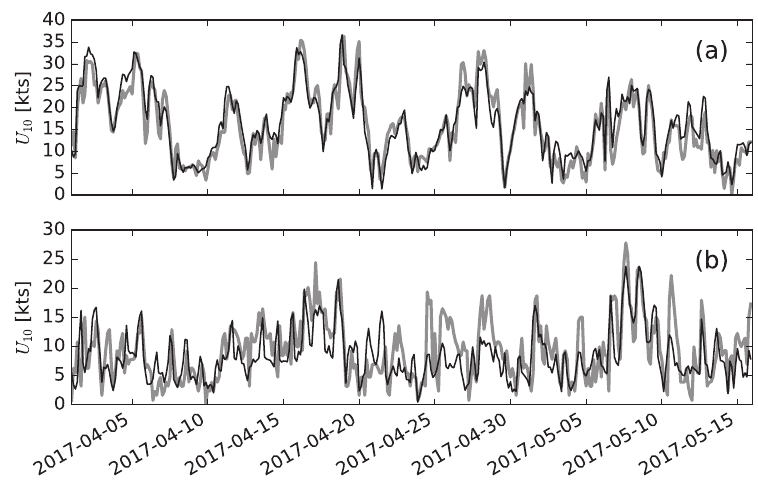
Figure 6. Comparisons between predictions and measurements of wind speed U 10 time series at Lion buoy ( a ) and at the Poetto beach ( b ). Thick gray line: observations; thin black line: predictions.